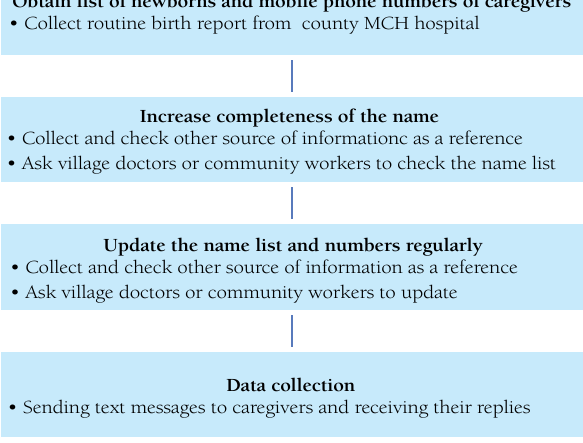
Figure 2. Procedure of text messaging data